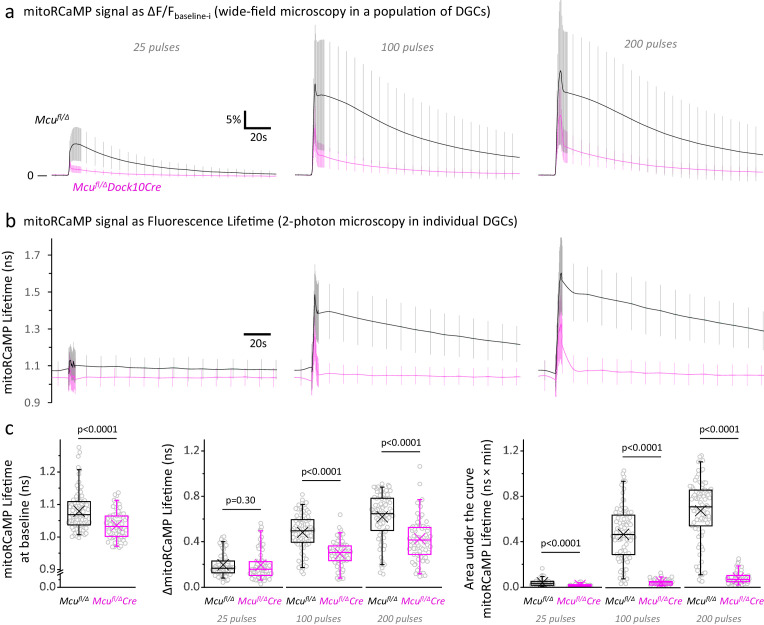
Mitochondrial Ca2+ levels at rest and during stimulation are lower in DGCs from Mcufl/Δ Dock10Cre mice, compared to Mcufl/Δ control mice.(a) Fluorescence signals from a mitochondrial matrix-targeted Ca2+ sensor (mitoRCaMP) in a population of hemizygous control DGCs (Mcufl/Δ) and MCU-KD DGCs (Mcufl/Δ Dock10-Cre), imaged using wide-field microscopy. The baseline before each stimulation (Fbaseline-i) was subtracted from the raw trace and average traces of the mitoRCaMP signal were expressed as the ΔF/Fbaseline-i ratio (mean ± SD, sample sizes as in Figure 3b, Left panel). In the control DGCs, the Ca2+ signal is mainly slowly declining, whereas a fast initial peak is more prominent in the MCU-KD DGCs. (b) Representative traces of the mitoRCaMP lifetimes in individual DGCs, imaged using two-photon microscopy. Data represents the mean ± SD (calculated with the number of neurons) in Mcufl/Δ mice (Nneurons = 89, Nslices = 13 and Nmice = 5) and Mcufl/ΔDock10Cre mice (Nneurons = 73, Nslices = 12 and Nmice = 4). (c) The mitoRCaMP lifetimes at baseline in DGCs from Mcufl/ΔDock10Cre mice are smaller than Mcufl/Δ mice, which indicates a lower [Ca2+]MITO in resting MCU-KD neurons. The maximum magnitude of the mitoRCaMP transient (ΔmitoRCaMP Lifetime) was also decreased in MCU-KD neurons when stimulated with 100 or 200 pulses. Similar to the fluorescence intensity, the area under the curve of the mitoRCaMP lifetime traces was strongly diminished in MCU-KD neurons, indicting a reduced Ca2+entry into the mitochondria at all the stimulations tested. A Student’s t test or a Welch’s t-test was used for comparisons between normally distributed data; otherwise a non-parametric Mann-Whitney test was used.